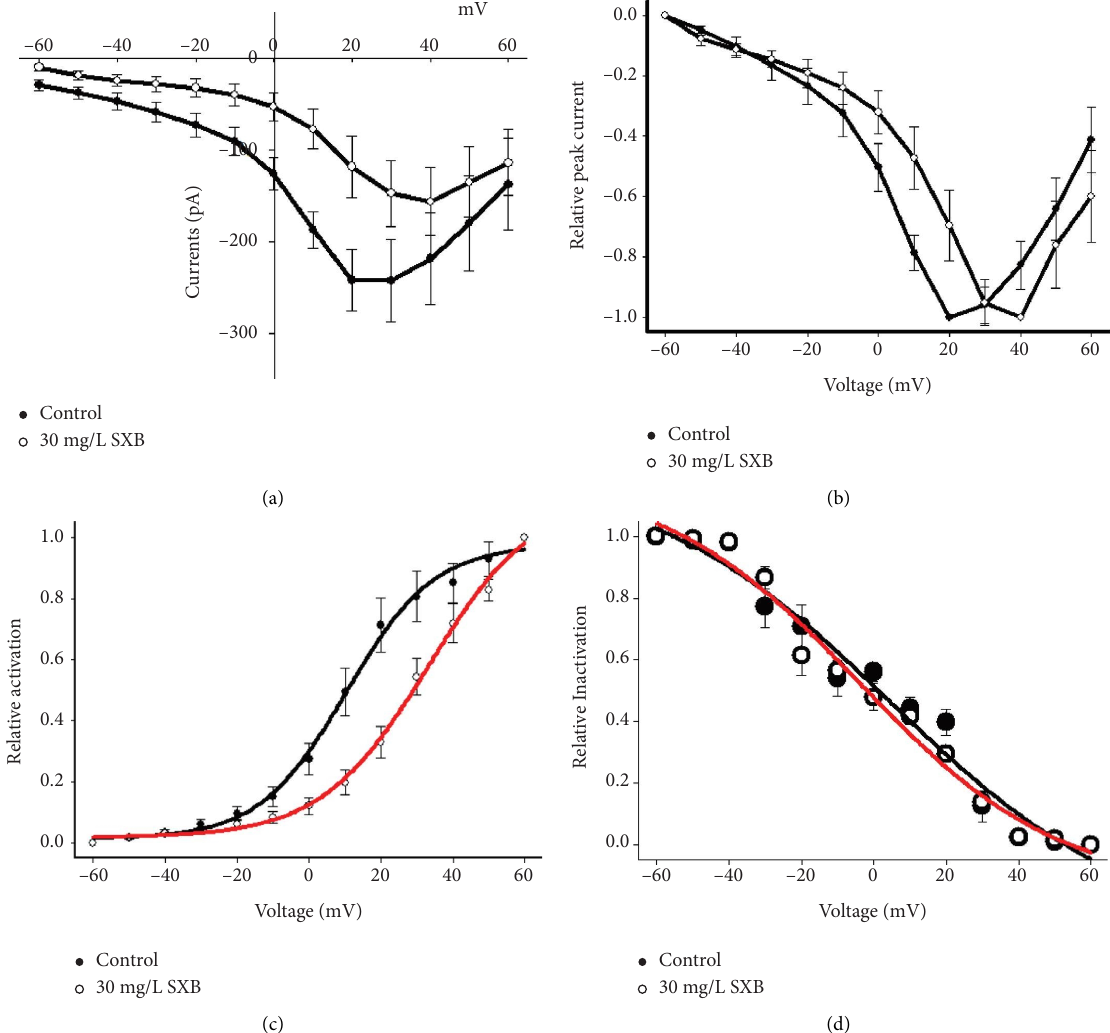
Figure 6: Te activation and inactivation curves of hCaV1.2 currents with and without 30mg/L SXB perfusion. (a) Te steady-state activation curve, (b) relative peak current curve, (c) relative activation, and (d) inactivation curves of control ( n � 11) and 30mg/L SXB ( n � 7) were obtained from hCaV1.2 current